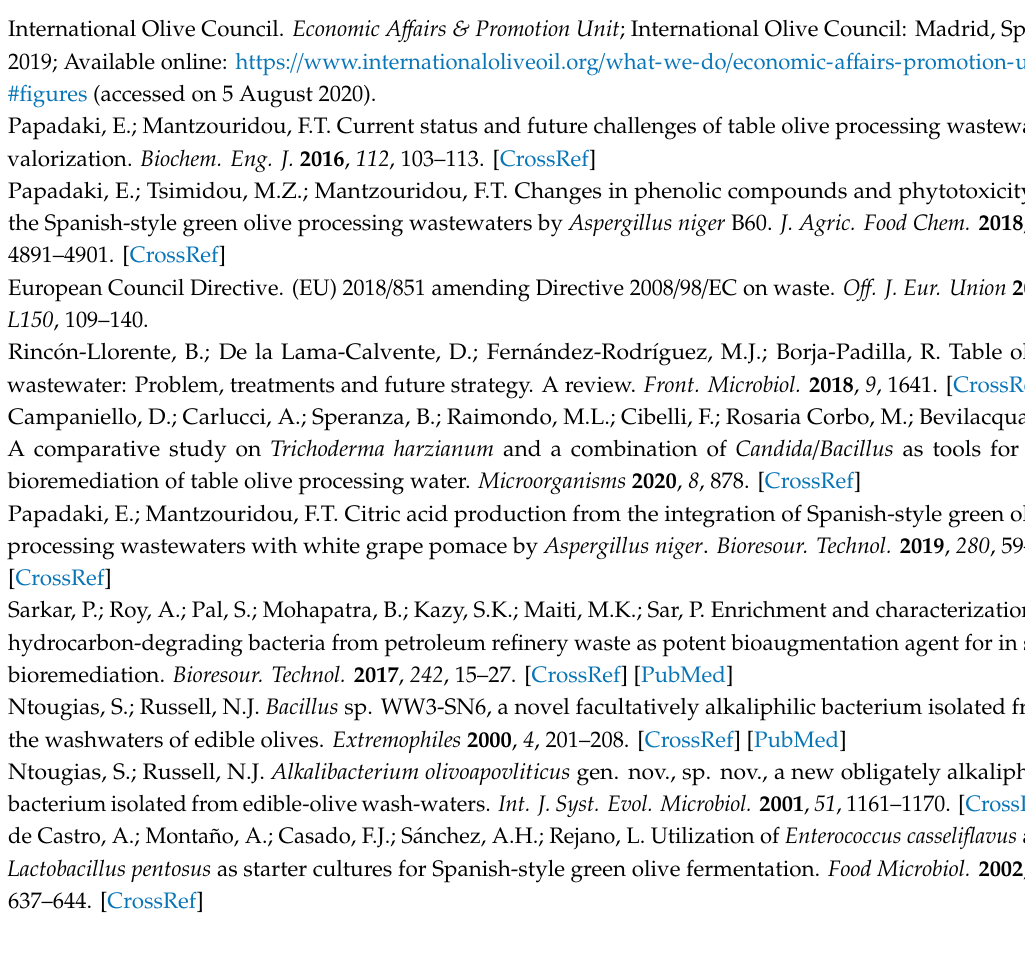
Table S1: Levels of factors in actual and coded values used in the experimental design; Figure S1: Changes in the pH value during the spontaneous fermentation of Spanish-style green olive processing wastewaters with